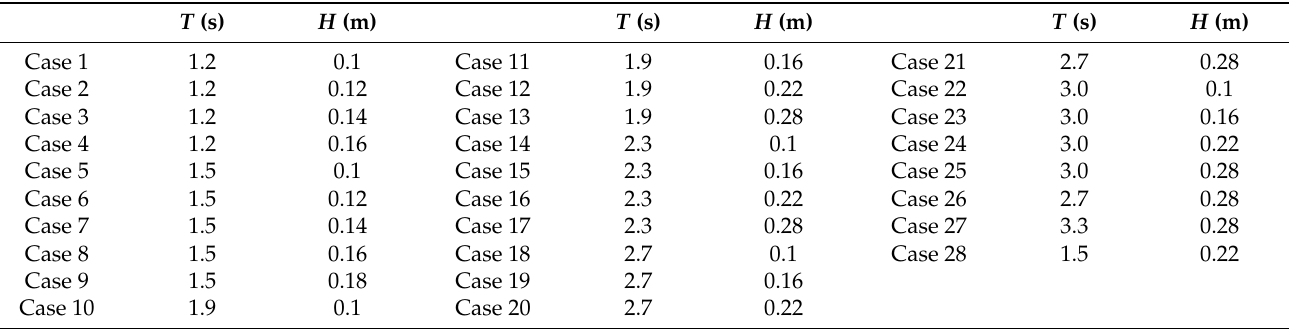
Table 6. Low (high) density group conditions.